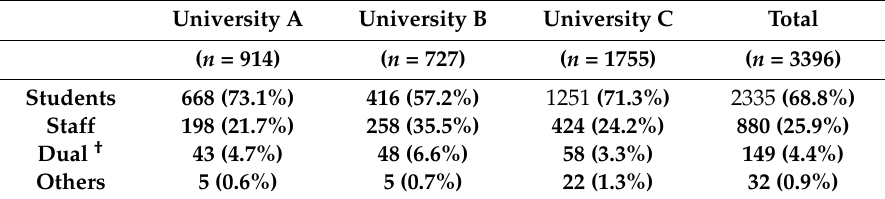
Table 2. E-survey respondents according to university and status.